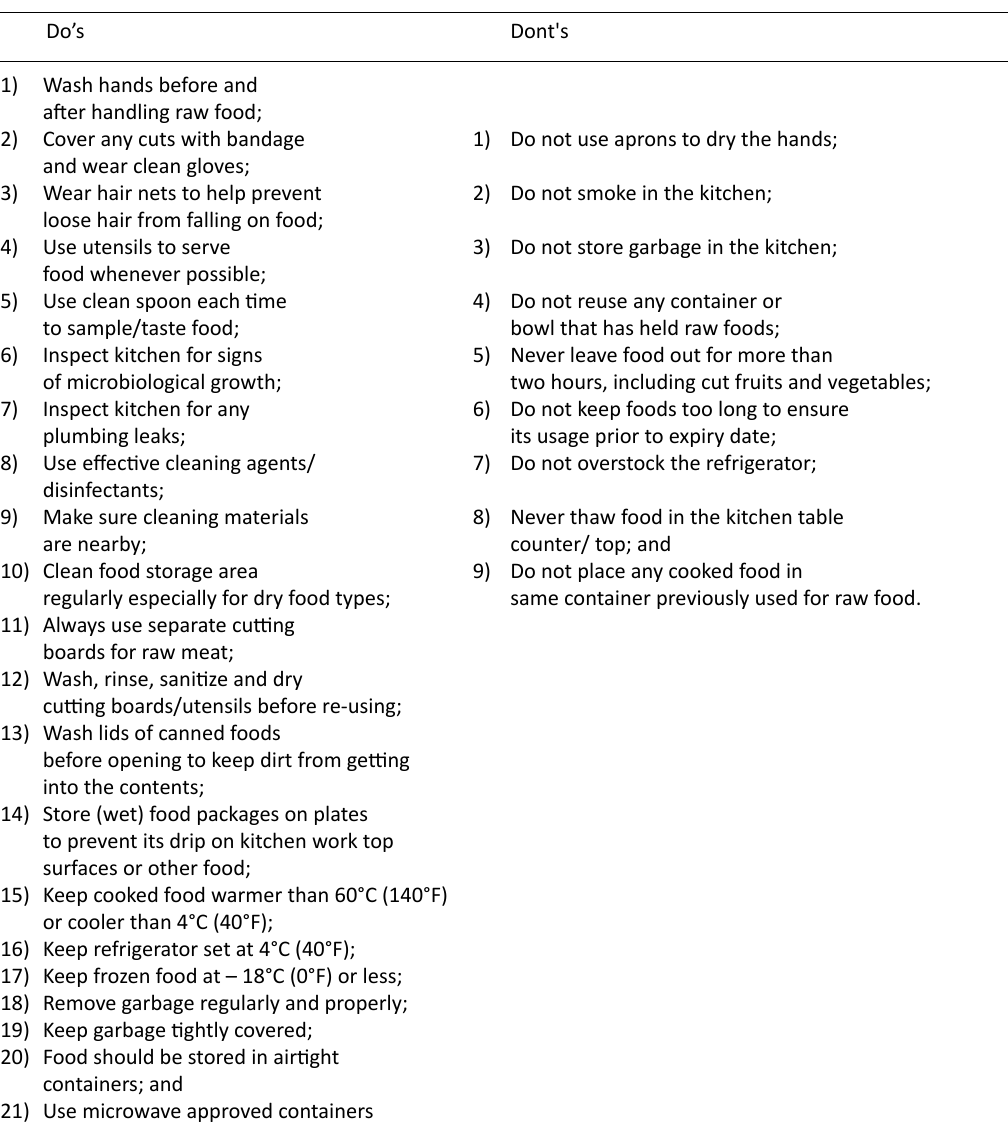
table 2: Basic/fundamental do’s and don’ts of food hygiene/ microbiological safety (FHMS) applicable to